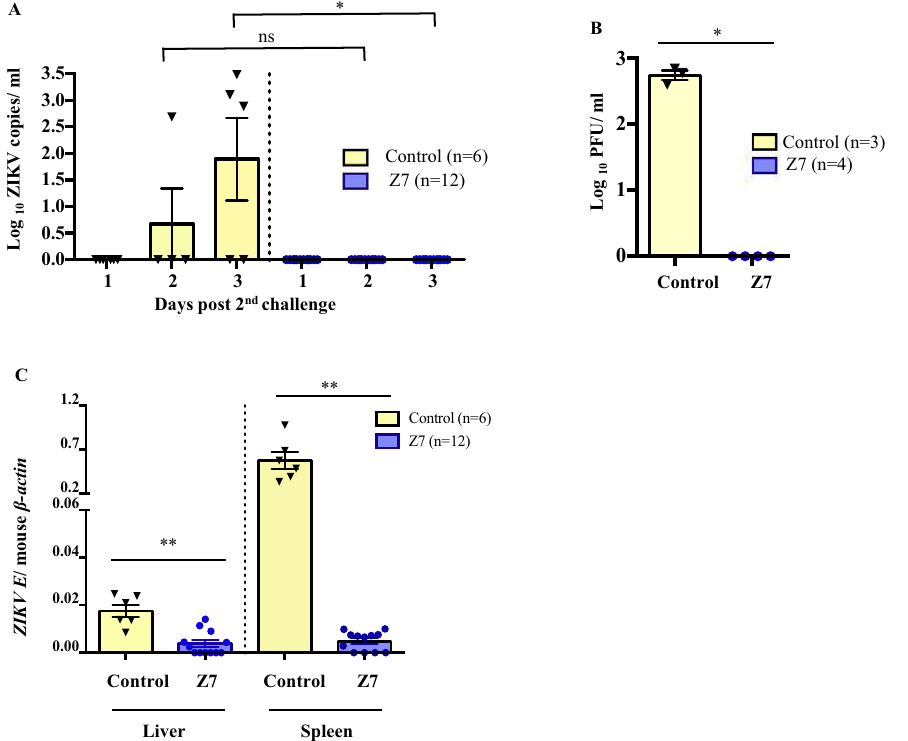
Fig. 6 Z7 induces sterilizing immunity in Ifnar1 − / − mice against an epidemic ZIKV strain infection. Four-week-old Ifnar1 − / − mice were inoculated with 1 × 10 5 FFU of Z7 (G10) or PBS as control via footpad. On D42 p.i., the mice were challenged with 1 × 10 5 PFU of ZIKV (strain PRVABC59) via footpad. A , B Viremia. Mice were bled on D1 to D3 post-challenge (p.c.), and viremia was measured by ( A ) qRT-PCR on D1 to D3 p.c. and ( B ) plaque assay on D3 p.c. samples. C Viral load in the liver and spleen tissues. Z1 or Z7-infected mice were sacri fi ced on D3 p.i. to harvest the liver and spleen. The viral load in the tissues was measured by qRT-PCR and expressed as the ratio of ZIKV E to mouse β -actin . Data were compared with Mann – Whitney U tests ( A , B ), a two-tailed Student ’ s t -test ( C ) and presented as mean ± s.e.m. with * p < 0.05, and ** p <